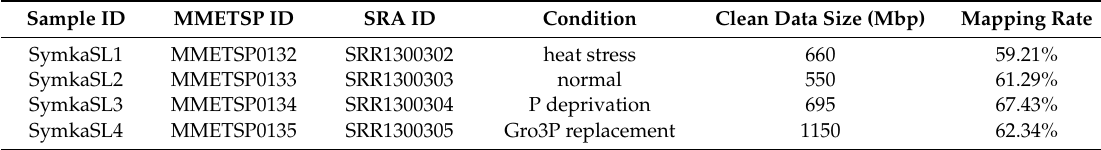
Table 1. RNA-seq information of F. kawagutii .